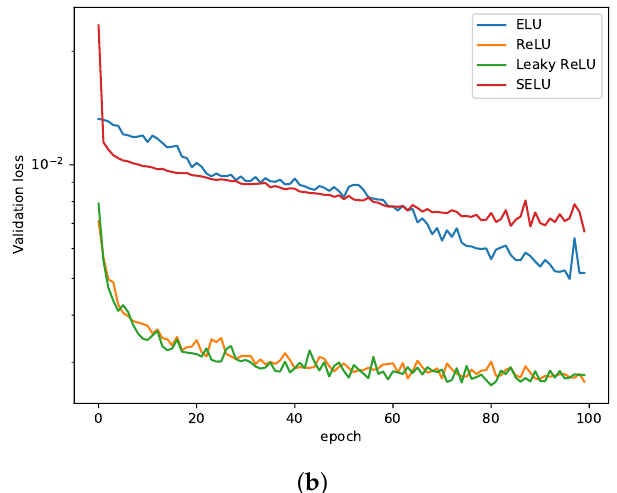
Figure 21. Comparison of the training loss and validation loss for various activation functions with log scale. Three hidden layers and 512 neurons were used for the 3D-truncated icosahedron tensegrity example. ( a ) Training loss. ( b ) Validation loss.